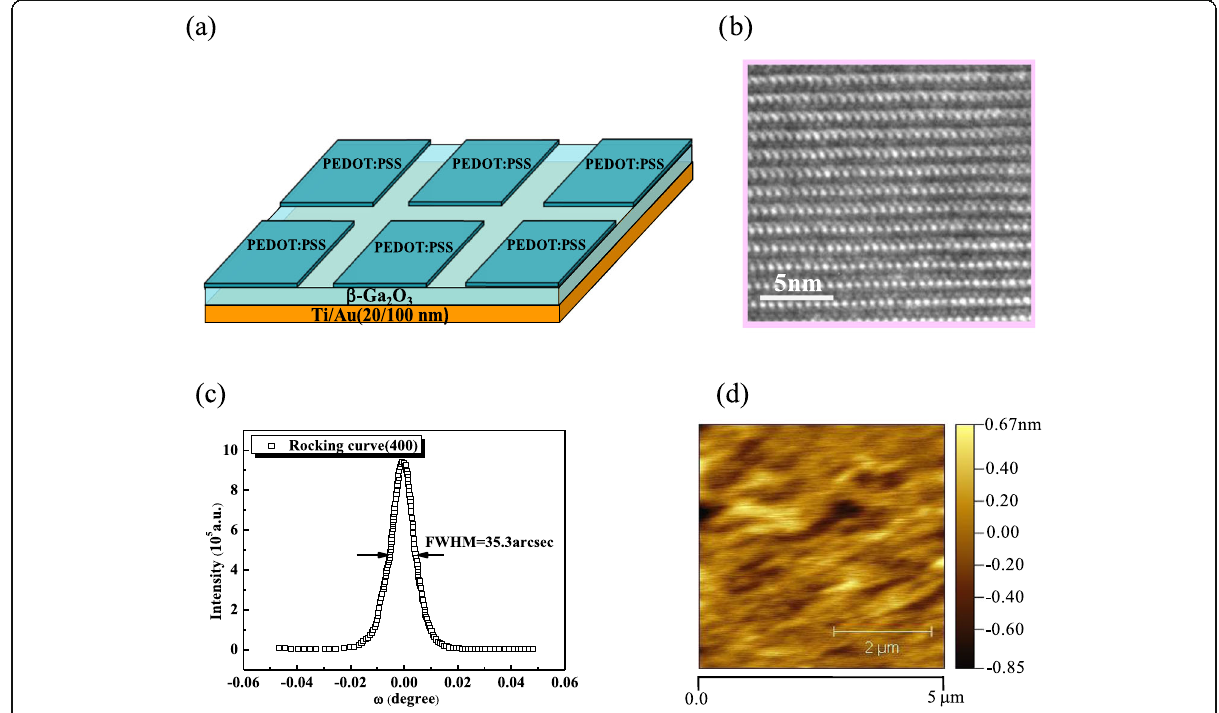
Fig. 1 Schematic diagram of the hybrid PEDOT:PSS/ β -Ga 2 O 3 Schottky diode ( a ), HRTEM image ( b ), HRXRD rocking curve of the (400) plane ( c ), AFM image of β -Ga 2 O 3 flake obtained from β -Ga 2 O 3 substrate by mechanically exfoliation, showing a high crystal quality and smooth surface ( d